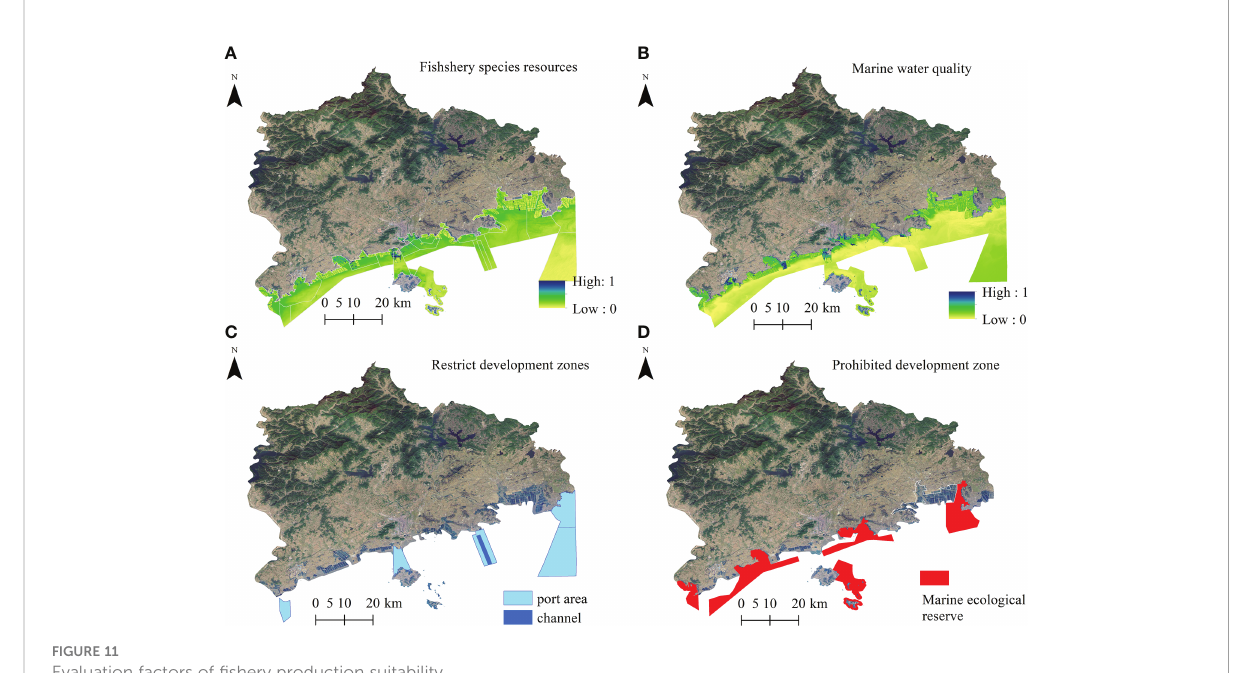
FIGURE 11 Evaluation factors of fi shery production suitability.